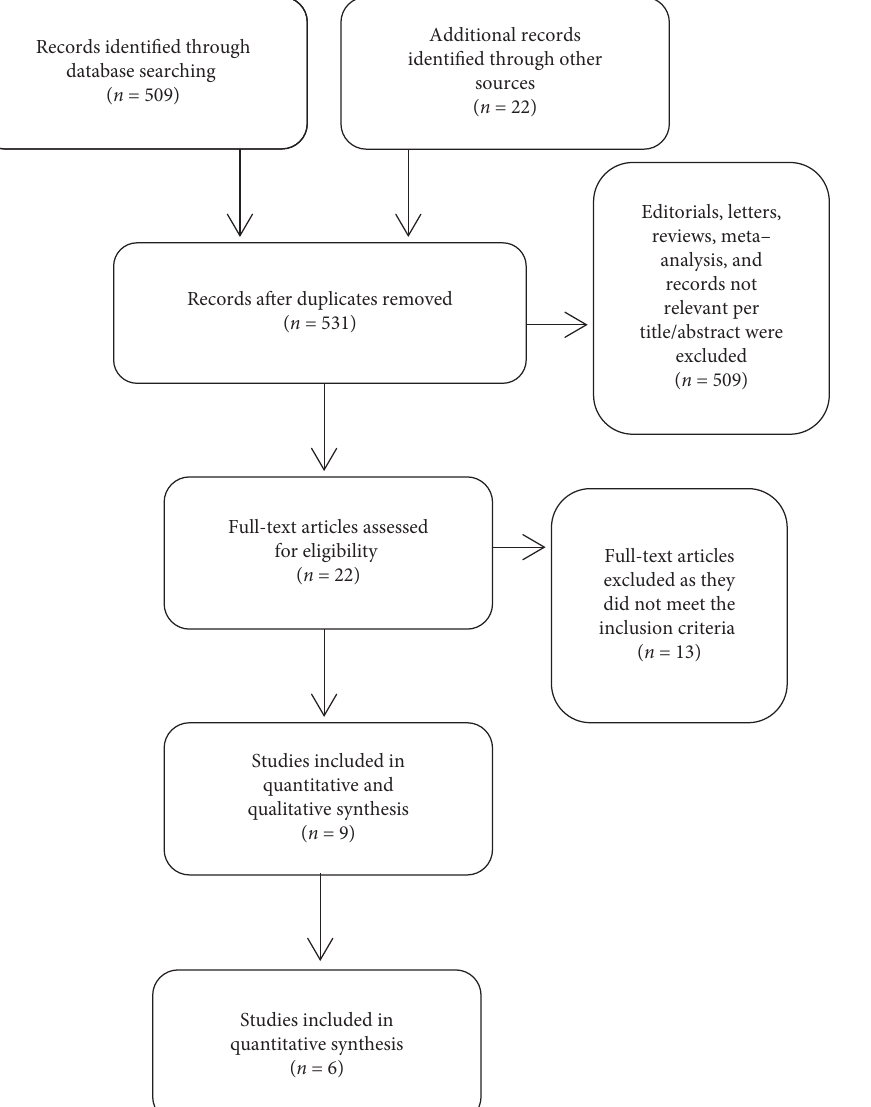
Figure 1: Details of the search